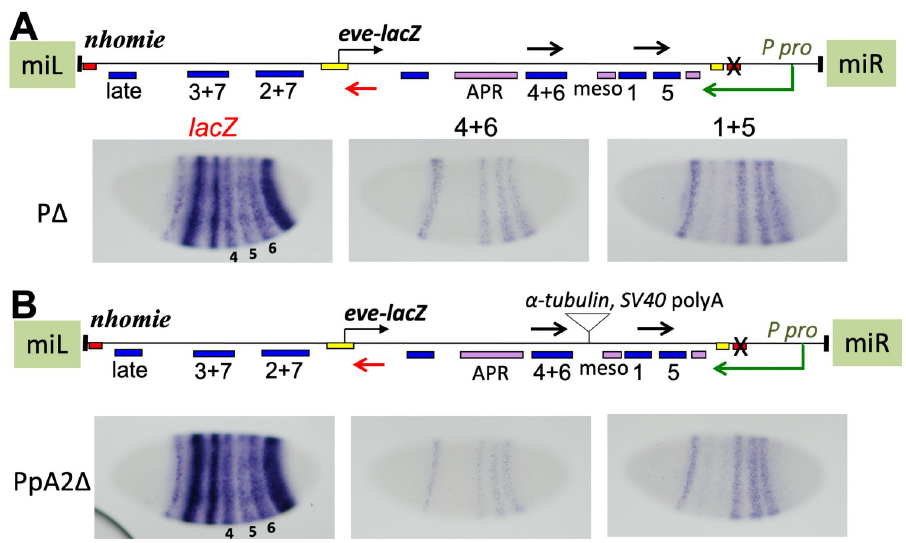
Fig 8. Insertion of polyA-addition signals weakly attenuates read-through transcription from a P-element promoter and correspondingly reduces repression of the eve promoter. eve-lacZ and flanking P-element promoter- driven RNA expression in stage 5 embryos from eve pseudo-loci, inserted at the same MiMIC site as in Fig 4, but in the opposite orientation. All loci have homie replaced with phage λ DNA (refer to maps). Positions and orientations of the RNA probes used are shown as black and red arrows in the maps. Images are labeled with black lettering corresponding to black arrows, or red lettering corresponding to the red arrow. The loci in A (P Δ , also used in Fig 4B) and B ( PpA2 Δ ), differ only in the insertion of a tandem array of polyA-addition signals, one from α -tubulin and two from SV40 , at the position shown in the map in